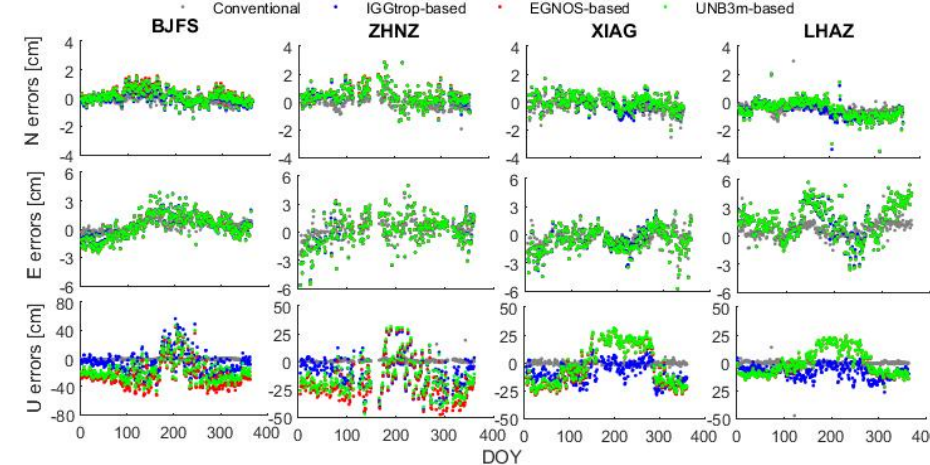
Figure 8. Time series of positioning errors for the conventional, IGGtrop-based, EGNOS-based and UNB3m-based PPP solutions at stations of BJFS, ZHNZ, XIAG and LHAZ, the DOY represents the day of year in 2012.